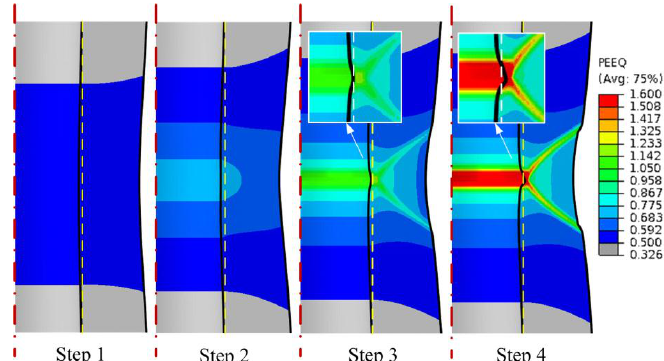
Figure 11. Offset status change of the inner wall in a tube with OD 0 = 8mm and WT 0 = 2mm.